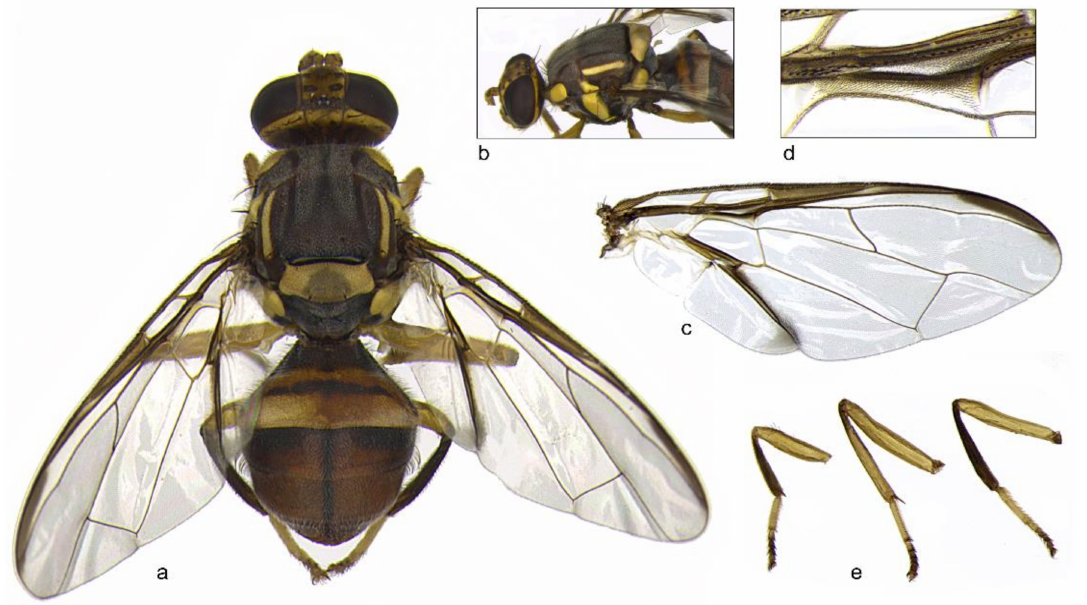
Figure 2. Bactrocera dorsalis male (specimen BD_2): dorsal view ( a ); lateral view with particular of the postpronotal lobe and lateral vitta ( b ); right wing ( c ); microtrichia pattern in cell br ( d ); and fore, mid, and hind legs ( e